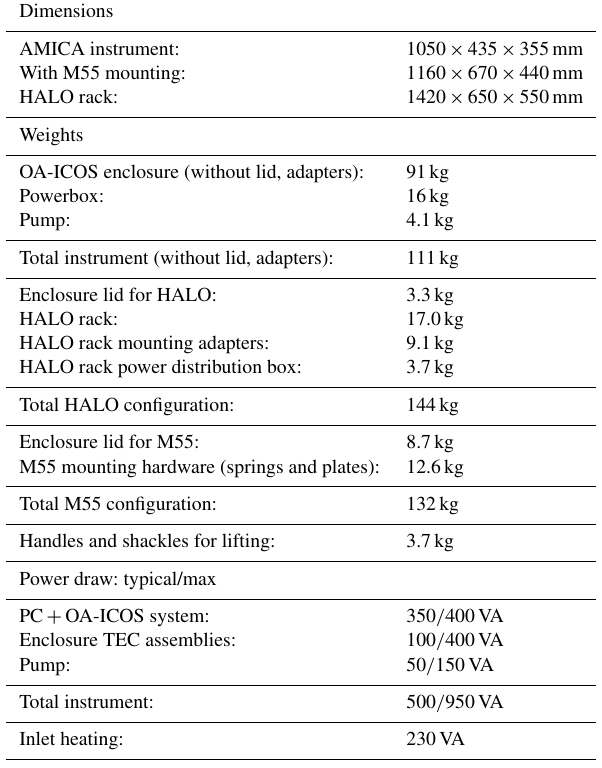
Table 1. Dimensions, weights and power draw of AMICA itemized for different parts and for the two different aircraft configurations. Note that TEC is thermoelectric